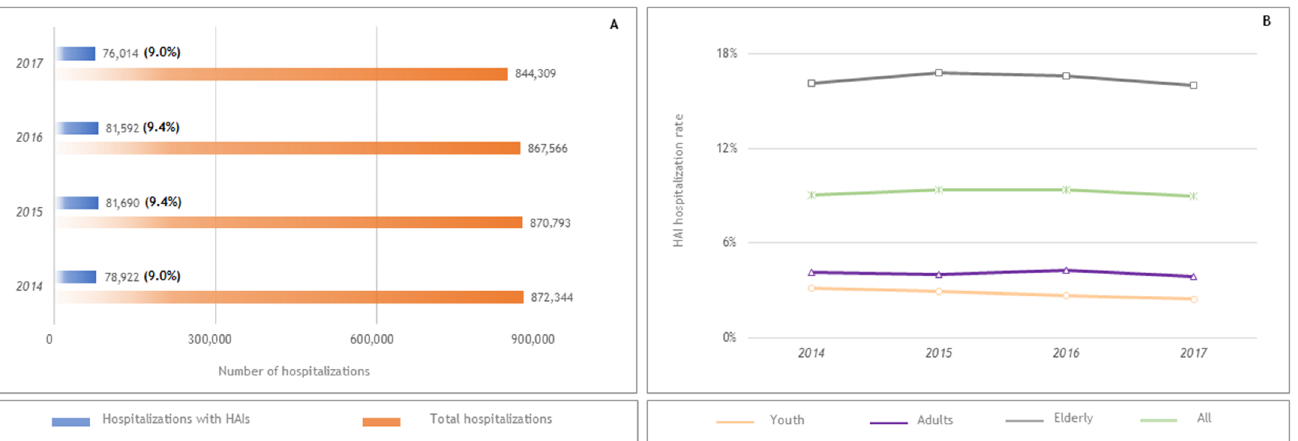
Table 2. Sociodemographic and clinical characteristics of patients admitted in mainland Portuguese public hospitals with HAIs. Characteristics Total Youth Adults Elderly Total HAI hospitalizations, n (%) 318,218 (100.0) Age, (years), Median,